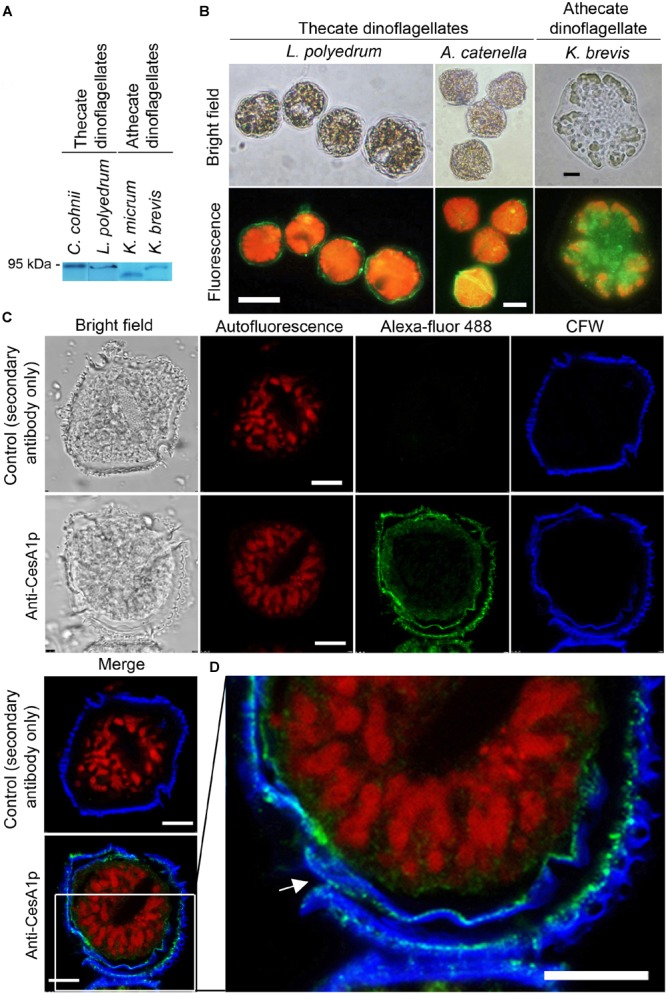
Cortical localization of CesA1p in dinoflagellates. (A) Western blot analysis of cell lysates from thecate and athecate dinoflagellates. (B) Fluorescence photomicrographs of whole cells labeled with anti-CesA1p antibody. (C) Confocal images showing the immunofluorescence-labeled cryosections prepared from L. polyedrum cells. Green fluorescence (Alexa Fluor 488 goat anti-rabbit IgG), corresponding to CesA1p, was localized to margins of overlapping CTPs; the continuity over one CTP was demarcated in enlarge image in (D). CFW fluorescence (Blue) also localized to this layer. CTPs are not flattened but three-dimensional structures with different front and back side (Figure 1A,B). Red fluorescence corresponded to the auto-fluorescence of chloroplast pigments. (D) CesA1p immunofluorescent pattern in cortical region with higher magnification. Its continuity around a CTP was highlighted with arrow. Antigen-purified anti-CesA1p antibody was used throughout the experiments. Scale bars represent 10 μm.